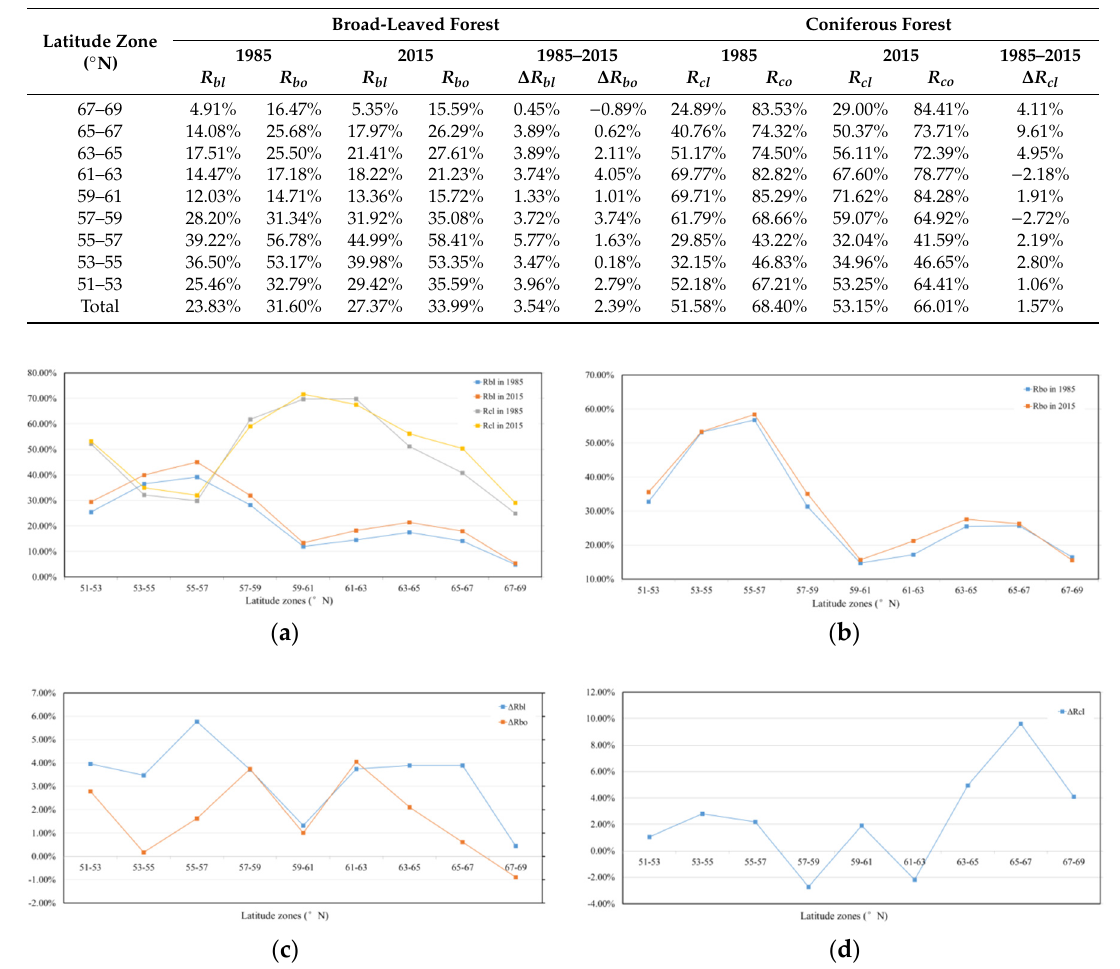
Figure 8. Spatial divergence of the cover and change of forest species with different latitude zones: ( a ) R bl and R cl in 1985 and 2015; ( b ) R bo in 1985 and 2015; ( c ) Δ R bl and Δ R bo ; ( d ) Δ R cl .